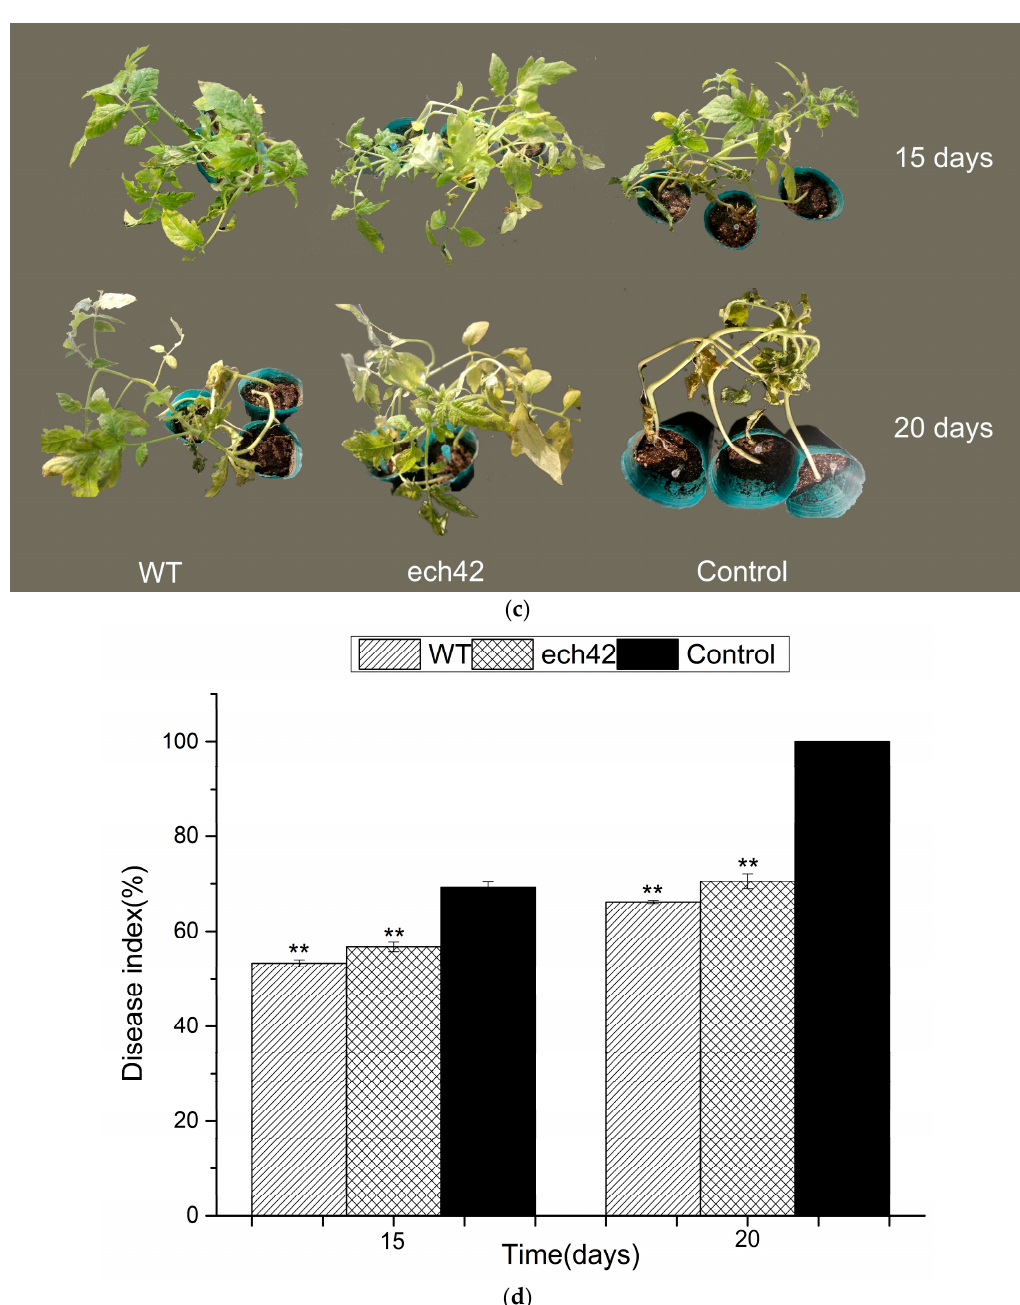
Figure 2. The biocontrol efficiency of B. amyloliquefaciens -ech42 against Botrytiscinerea on tomato plants. The prevention experiment ( a , b ): ( a ) Representative images of tomato plants treated with wild type B. amyloliquefaciens (WT), B. amyloliquefaciens -ech42 (ech42) or non-treated (control); ( b ) disease indexs in the prevention experiment at 15 and 20 days. The treatment experiment ( c , d ): ( c ) Representative images of tomato plants treated with wild type B. amyloliquefaciens (WT), B. amyloliquefaciens -ech42 (ech42) or non-treated (control); ( d ) disease index in the treatment experiment at 15 and 20 days. Differences between the treatment and control were analyzed using ANOVA and significant results are indicated by ** ( p < 0.01).